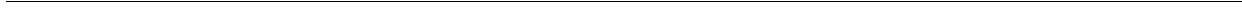
Figure 4 | Differential local regulation of cAMP signals is necessary for maximal stimulated inotropy. ( a ) Representative time course of global cytosolic cAMP change (top) and sarcomere shortening (bottom) recorded simultaneously in the same ARVM expressing the cytosolic FRETreporter EPAC-S H187 on application of 0.3nM ISO or ( b ) 100 m M IBMX. Inset at the top of a shows mean FRETchange measured in ARVM expressing the cytosolic